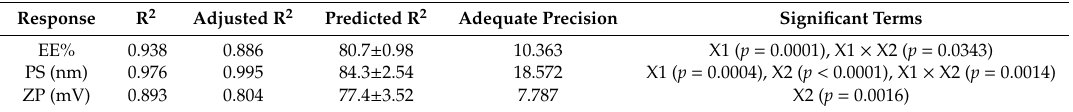
Table 2. Output results of the factorial design.